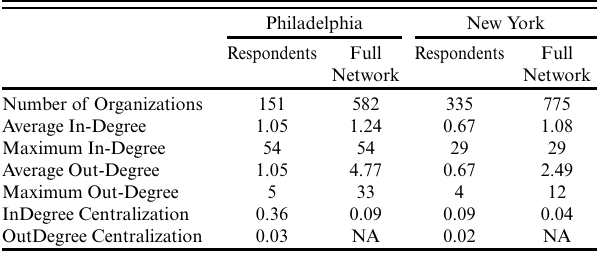
Table 2 . Network statistics for respondent and full civic environmental stewardship networks for Philadelphia and New York City.